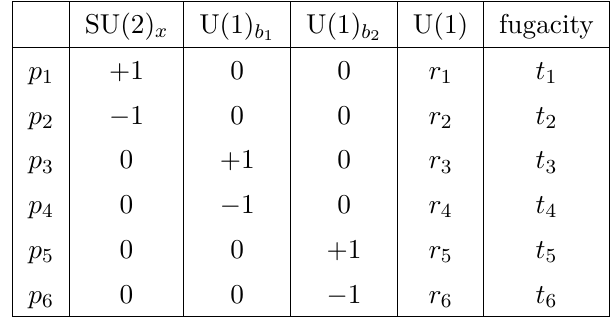
Table 31 . Global symmetry charges on the extremal brick matchings p i of Model